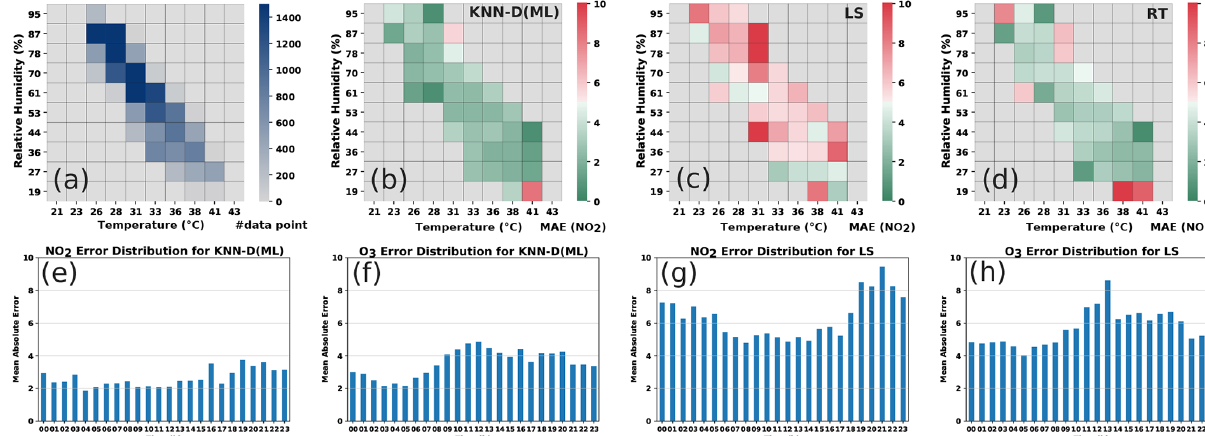
Figure 7. Analyzing error distributions of LS, KNN-D(ML) and RT. Panel (a) shows the number of training data points in various weather condition bins. Panels (b, c, d) show the MAE for NO 2 calibration offered by the algorithms in those same bins. Non-parametric algorithms such as KNN-D(ML) and RT offer poor performance (high MAE) mostly in bins that had fewer training data. No such pattern is observable for LS. Panels (e, f, g, h) show the diurnal variation in MAE for KNN-D(ML) and LS at various times of day. O 3 errors exhibit a diurnal trend of being higher (more so for LS than for KNN-D(ML)) during daylight hours when O 3 levels are high. No such trend is visible for NO 2 .